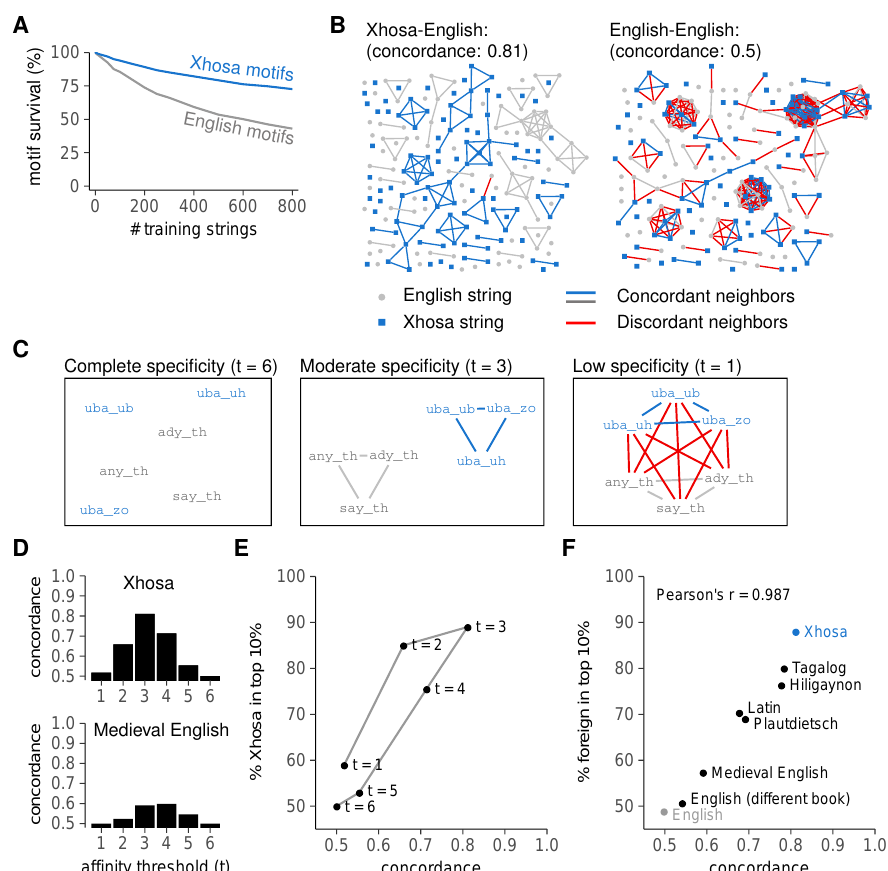
Figure 4. Language discrimination by an artificial immune system requires moderate cross-reactivity and dissimilar self- and foreign strings. ( A ) mean ± standard error of the mean (SEM) percentage of surviving motifs for English and Xhosa strings after negative selection (using threshold t = 3). Plot represents a different analysis of data shown in Figure 3C,D; ( B ) string similarity visualized in a graph where nodes (strings) are neighbors (connected by edges) if at least 5/million motifs in the pre-selection repertoire react to both; ( C ) cross-reactivity increases the number of edges between example English and Xhosa strings (demonstrated here for a few examples). Edges between strings from different languages are shown in red; ( D ) concordance in the English-Xhosa and English-Medieval English graphs for different thresholds t ; ( E ) concordance and discrimination between English and Xhosa for different thresholds t . Negative selection was performed on 800 English strings. Datapoint for t = 3 corresponds to the endpoint of Figure 3D; ( F ) language concordance versus enrichment of foreign strings among the top 10% most frequently recognized strings after negative selection ( t = 3, selection on 800 English strings). Pearson’s correlation coefficient r = 0.987,with 95% confidence interval [0.937, 0.997]. The control “English” compares two sets of English strings from the same book that was used for training (Moby Dick), whereas “English (different book)” compares unseen English strings from the training book to those from the Bible. The point "Xhosa" corresponds to the point “ t = 3” in Figure 4E. See also Figure